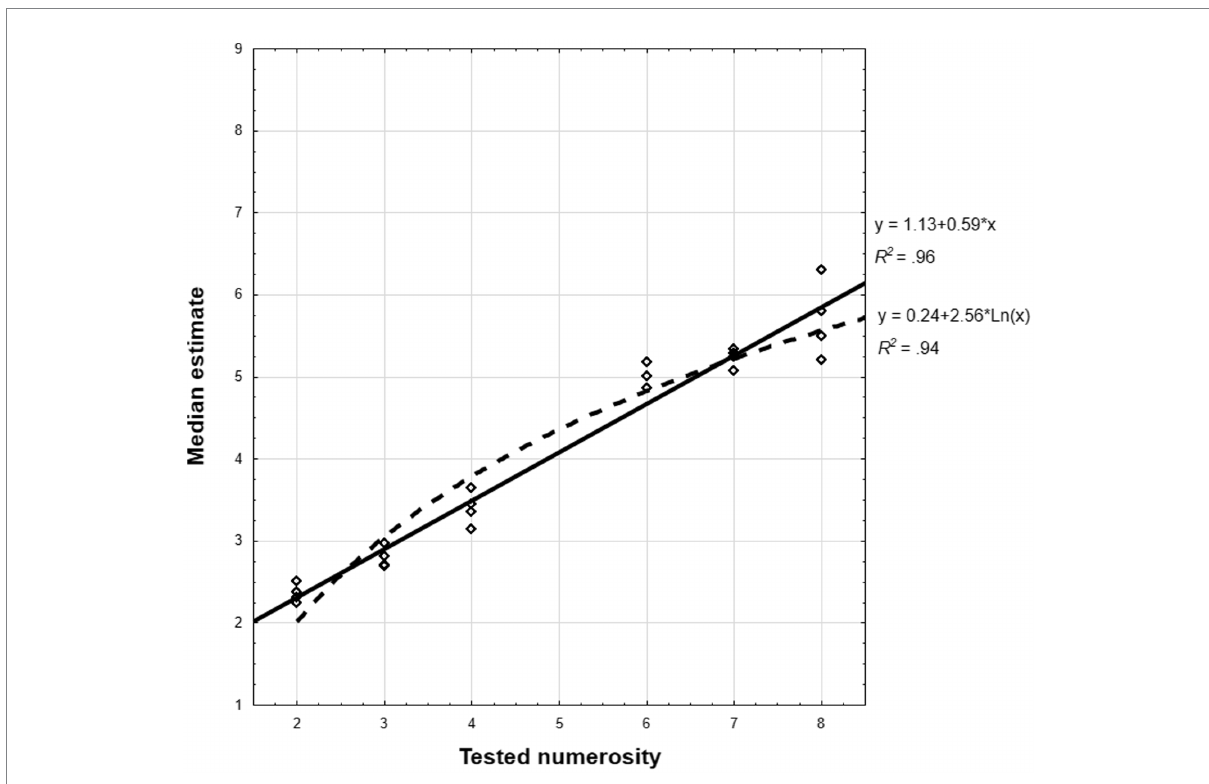
FIGURE 3 Experiment 2: 1–9 number-line: Distribution of linear and logarithmic model fit of group median estimates computed for each series separately. Regression equations and R 2 coefficients for the best fit linear and logarithmic model are provided on the right